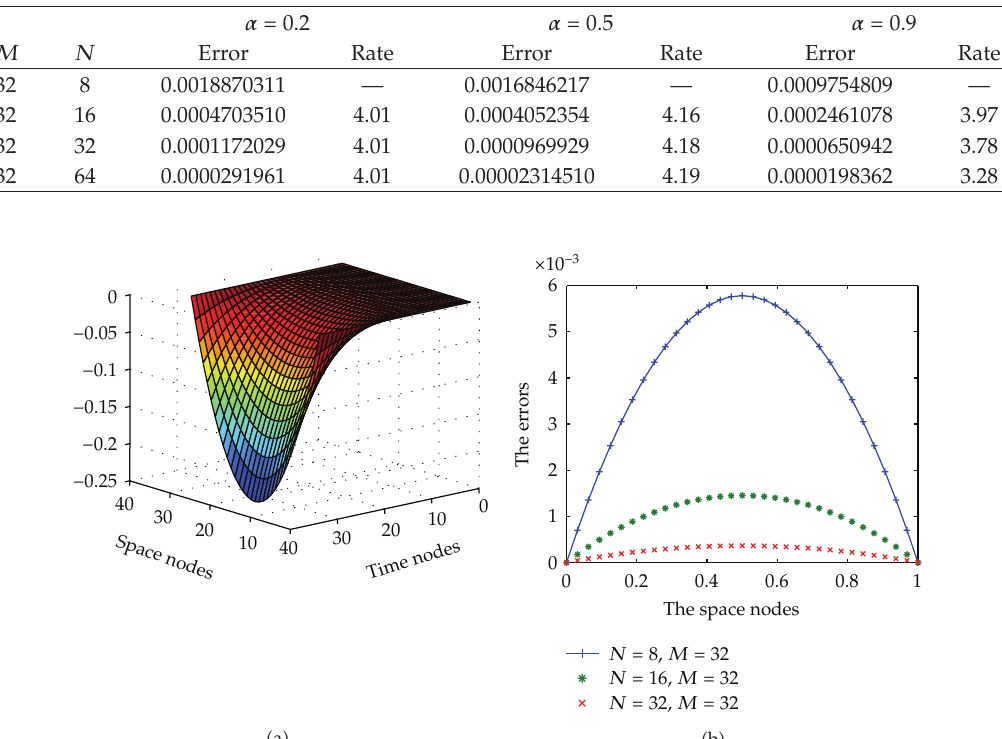
Table 1: Error table for Example 5.1.